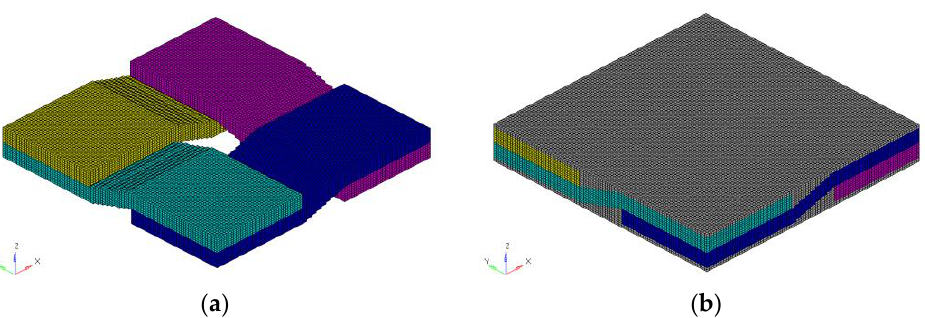
Figure 6. The finite element model for weave composite. ( a ) Mesoscopic model without considering the matrix. ( b ) Mesoscopic model considering the matrix.